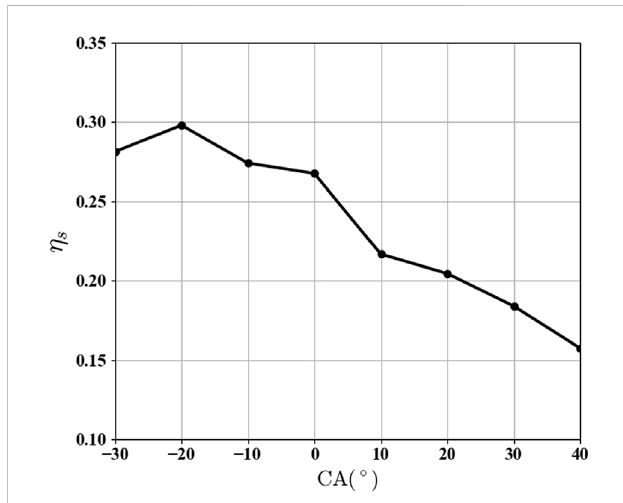
FIGURE 11 Distribution of spatially averaged fi lm cooling effectiveness with different compound